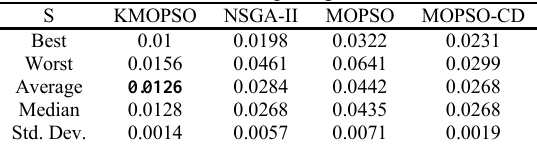
Table 3 . Results of the spacing metric for SCH.